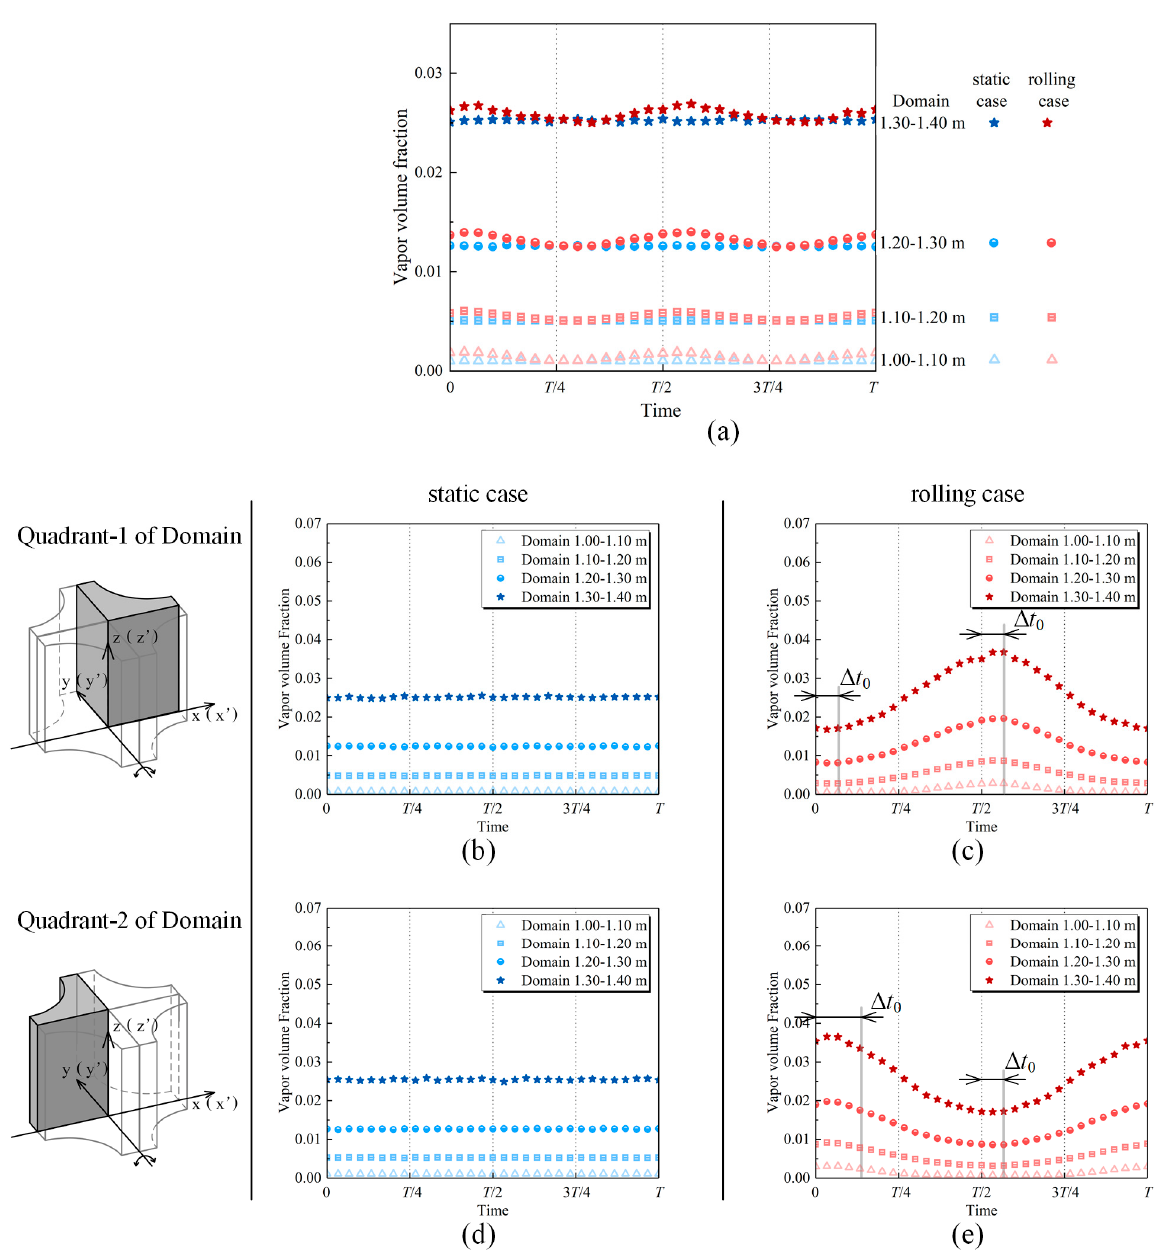
Figure 6. Instantaneous vapor volume fraction. ( a ) Domain; ( b ) Quadrant-1 in the static case; ( c ) Quadrant-1 in the rolling case; ( d ) Quadrant-2 in the static case; ( e ) Quadrant-2 in the rolling case.